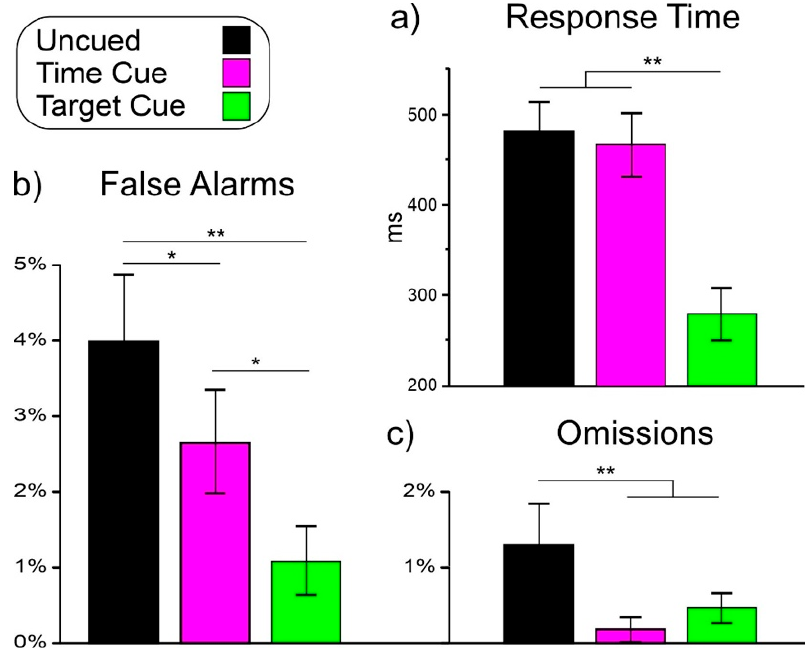
Figure 2. Behavioral results in the three tasks: ( a ) response time; ( b ) false alarms; ( c ) omissions. Vertical bars denote 0.95 confidence intervals. * p < 0.05, ** p < 0.01.